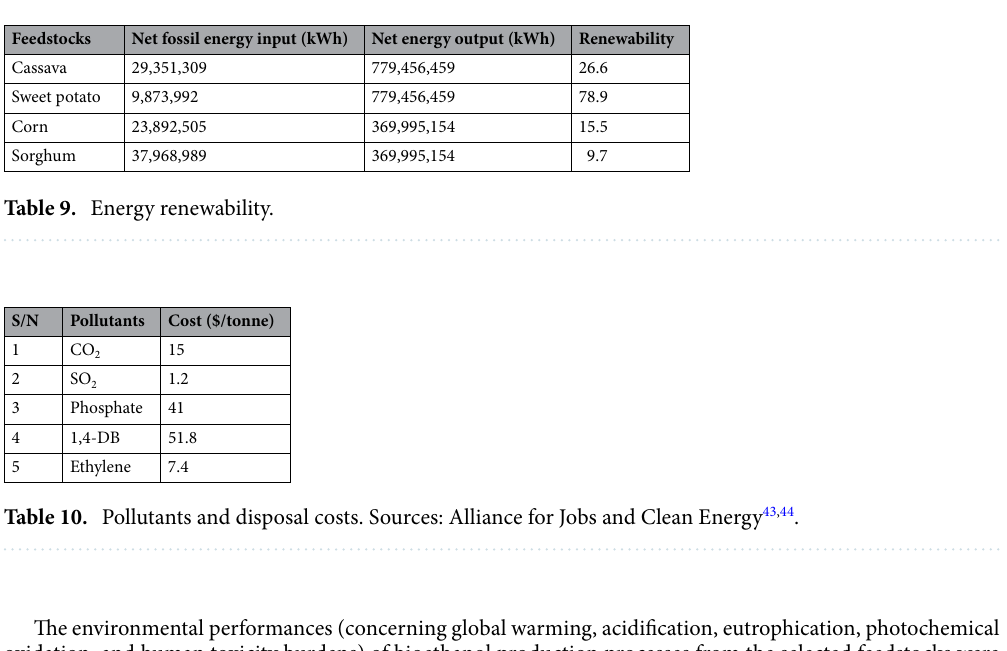
Table 11. This fossil fuel-derived CO 2 emission constituted a system bottleneck in the feedstock production phase. Upon assigning emission/discharge costs to the environmental pollutants as presented in Table 11, the overall emission cost of each processing plant was added to its annual operating cost and the economic parameters were